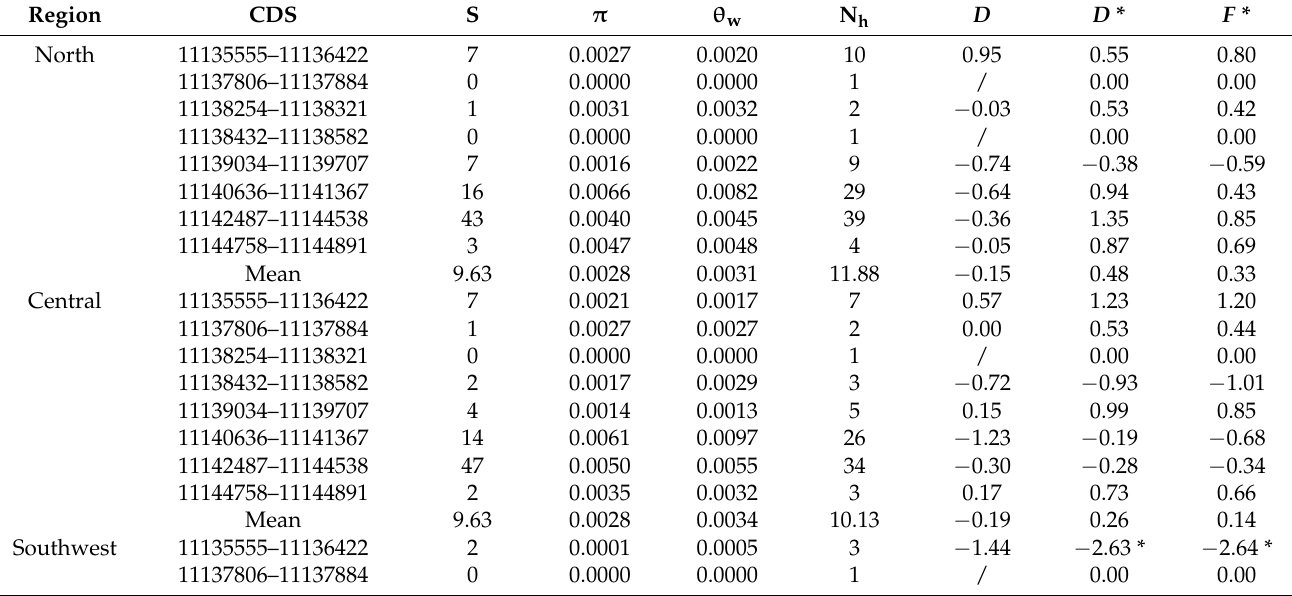
Table 4. Nucleotide diversity and neutral test in the CDS region of the REF6 gene. Region